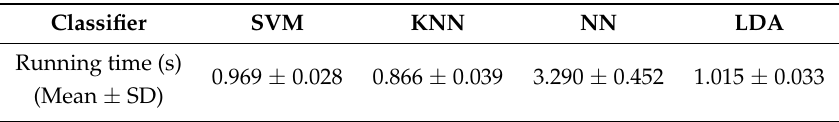
Table 5. Mean and standard deviation of the running time for different